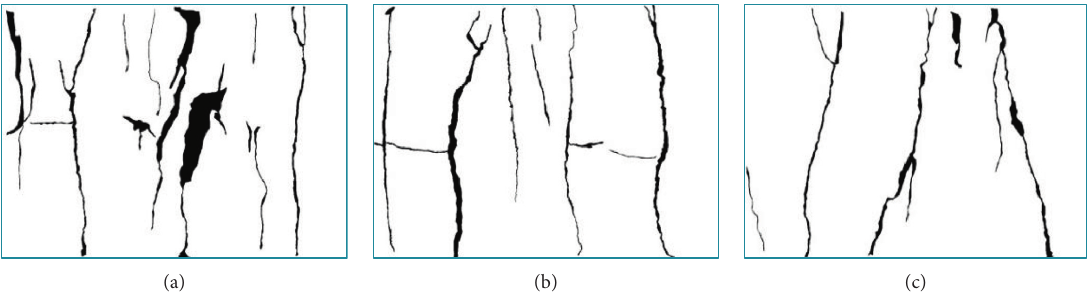
Figure 8: Binary images of WCST specimens under different numbers of dry-wet cycles. (a) N � 0 (b) N � 5. (c) N � 10.